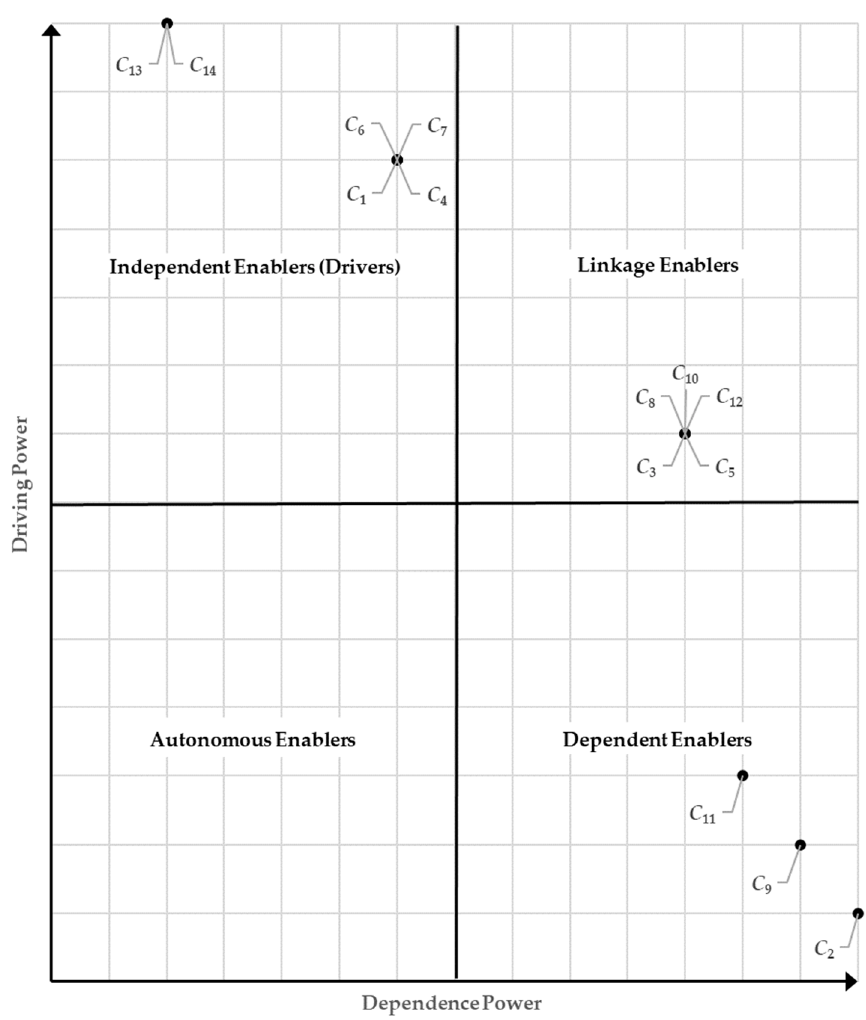
Figure 2. Cross-Impact Matrix Multiplication Applied to Classification (MICMAC) of critical Systems-Thinking-based leadership competencies as enablers to better construction safety perfor- mance.